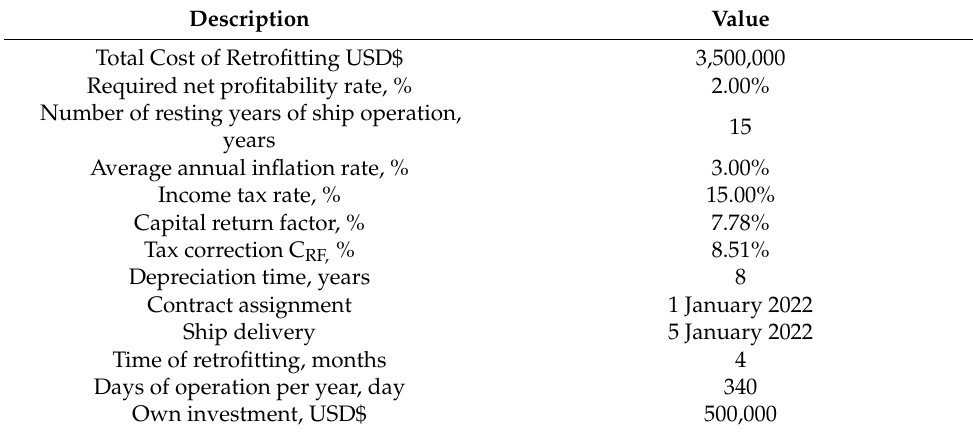
Table 10. Feasibility input data.